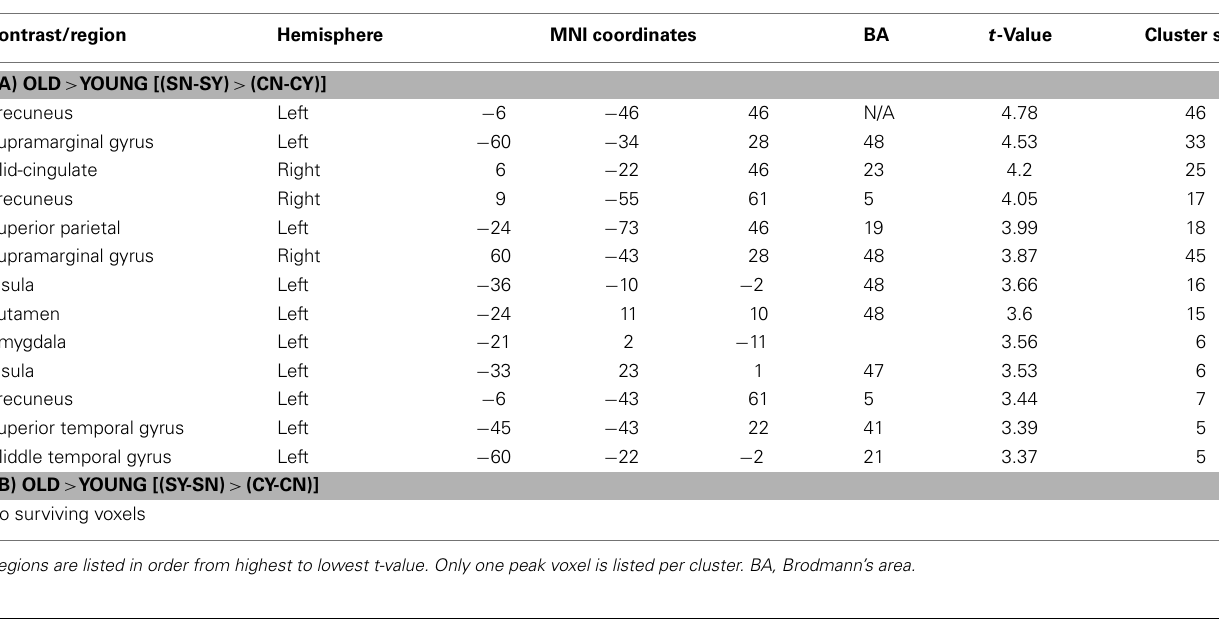
Table 4 |Age × stereotypicality ×